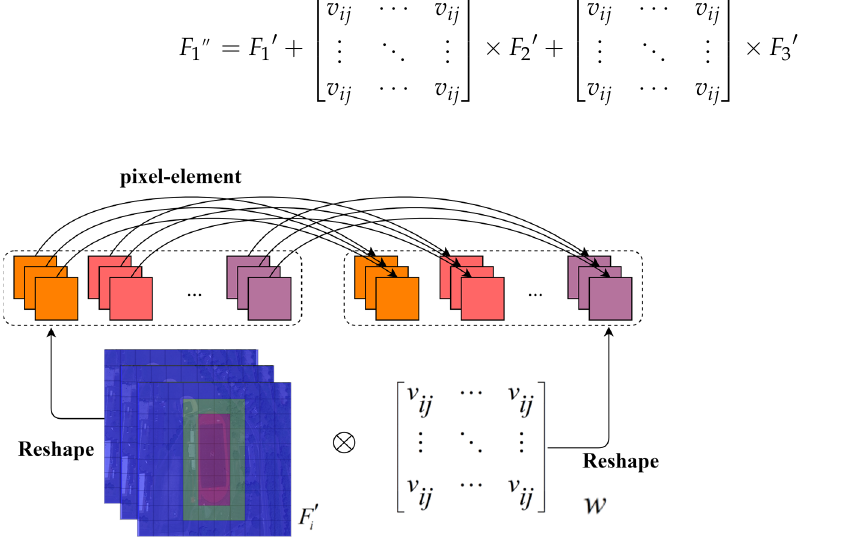
Figure 3. Adaptive feature-aware module structure.